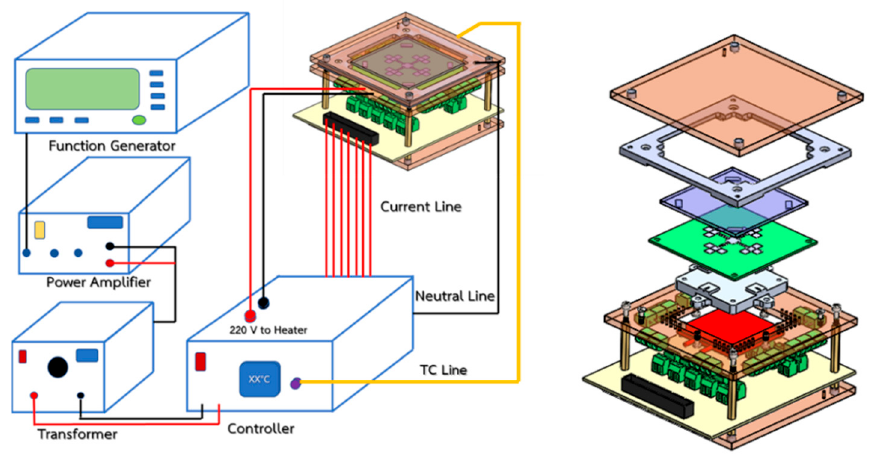
Figure 13. Schematic diagram of LAMP–LOC platform.